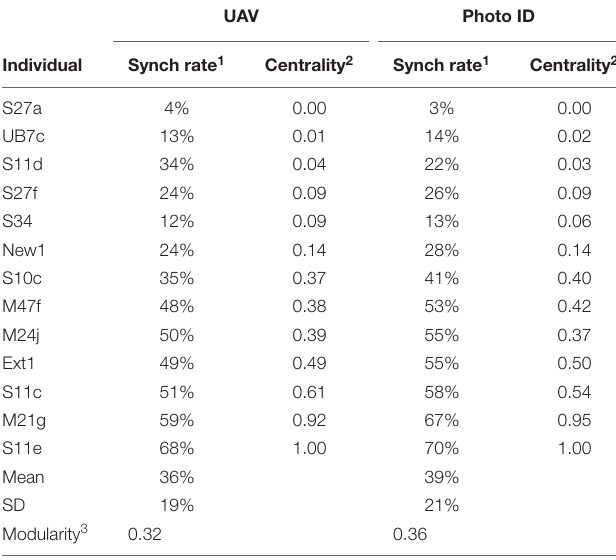
TABLE 1 | Measures of sociality compared between UAV and Photo ID.